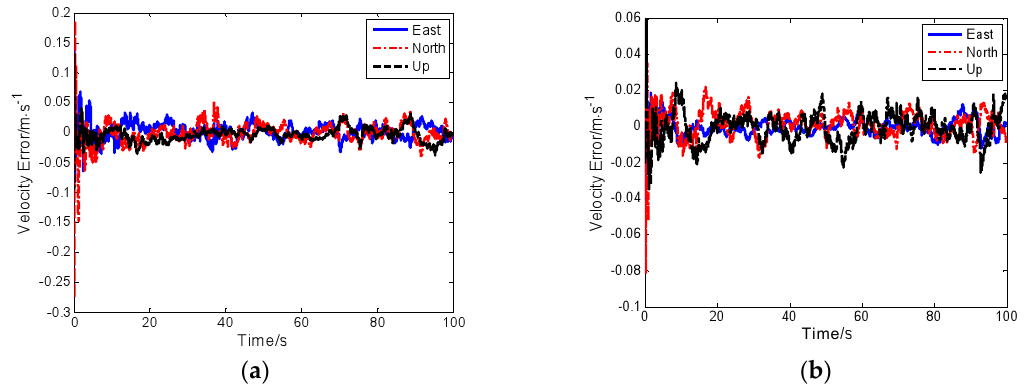
Figure 16. ( a ) Velocity error of the conventional ultra-tight integration. ( b ) Velocity error of the innovative ultra-tight integration.